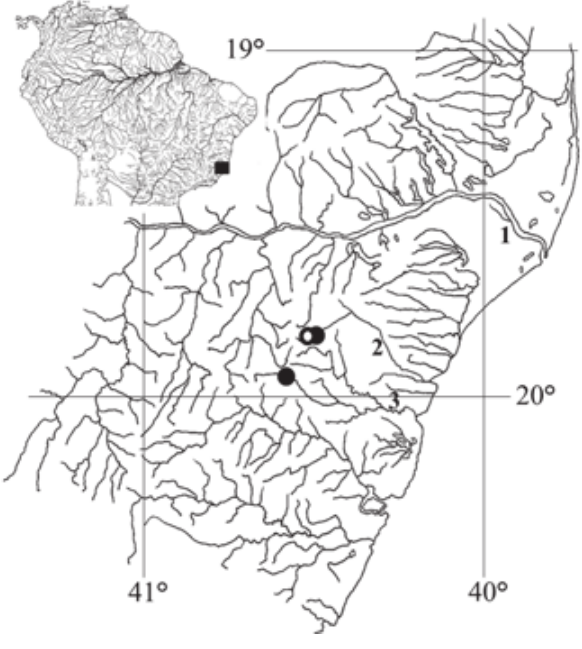
Fig. 5. Distribution of Pareirhaphis ruschii in eastern Brazil. 1, rio Doce. 2, rio Piraquê-Açu. 3, rio Reis Magos. Each dot covers more than one lot or locality. Open symbol is type-